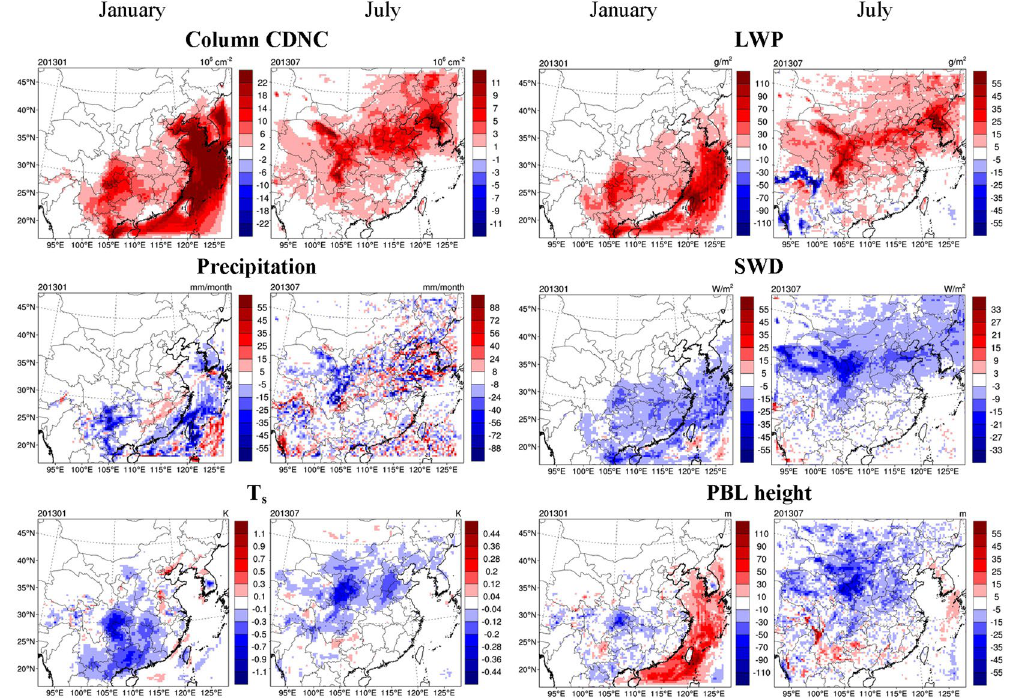
Figure 2. Impact of anthropogenic aerosols on meteorological variables through aerosol-cloud interactions, determined from the scenarios of BASE and PRSC10 (BASE minus PRSC10). The meteorological variables considered are column cloud droplet number concentration (CDNC), liquid water path (LWP), precipitation, downward shortwave radiation at surface (SWD), surface air temperature (T s ), and planetary boundary layer (PBL) height. This figure is produced using the NCAR Command Language (Version 6.2.1) [Software]. (2014). Boulder, Colorado: UCAR/NCAR/CISL/TDD.